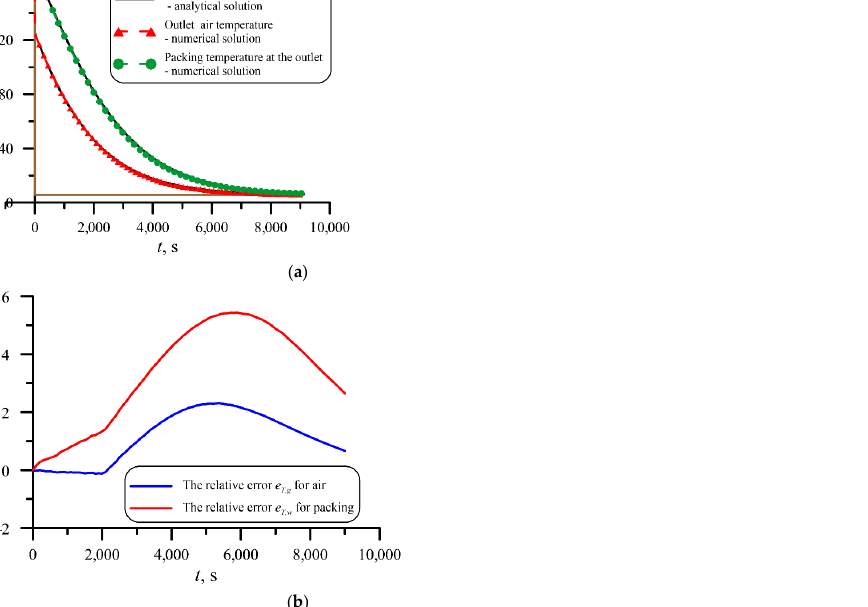
Figure 9. Air and packing temperature variations at the accumulator outlet determined for a step change in the air temperature from 600 °C to 20 °C of the air temperature at the accumulator inlet ( a ); and the relative difference between the temperature determined using the exact analytical formula and the finite-difference method ( b ).